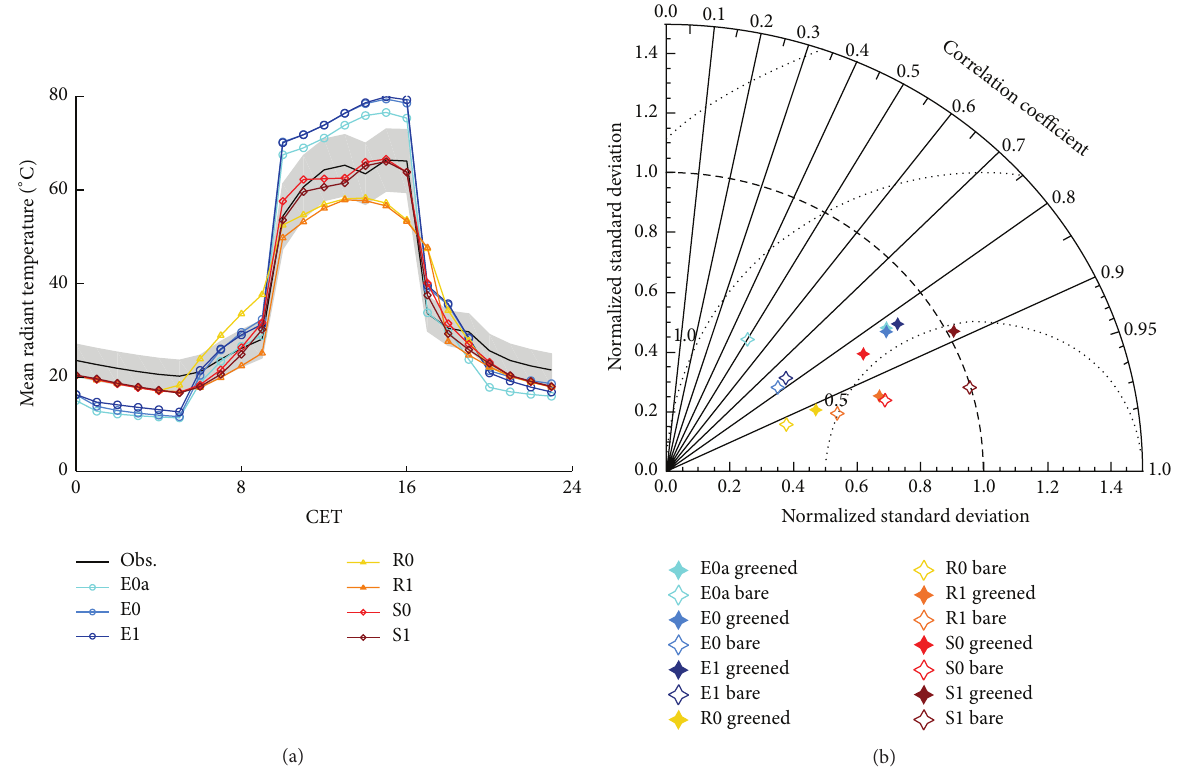
Figure 6: Mean radiant temperature on 7, 23, 2013, as observed and simulated (a) at the greened site and (b) Taylor-Diagram for the experiments with ENVI-met 3 (E0a), unforced (E0) and forced ENVI-met 4 (E1), RayMan without (R0) and with global radiation from observation (R1), and SOLWEIG without (S0) and with global radiation from observation (S1). The gray area indicates the accuracy range of the